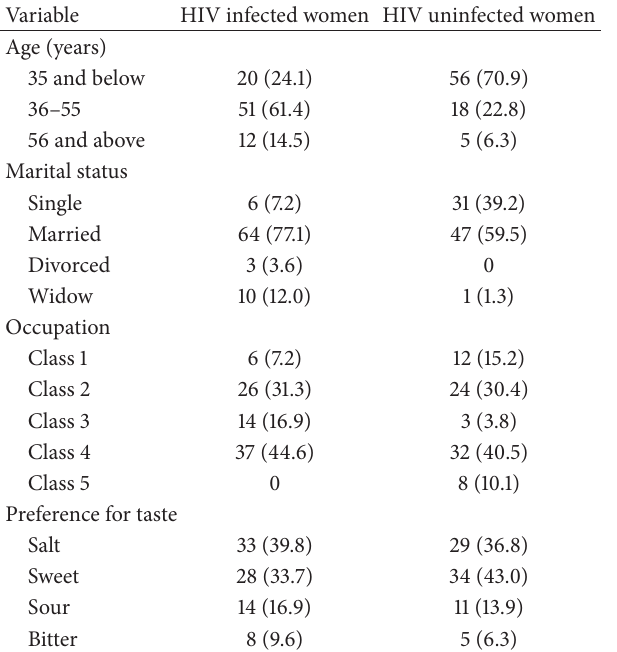
Table 1: Sociodemographic characteristics of the participants. Variable